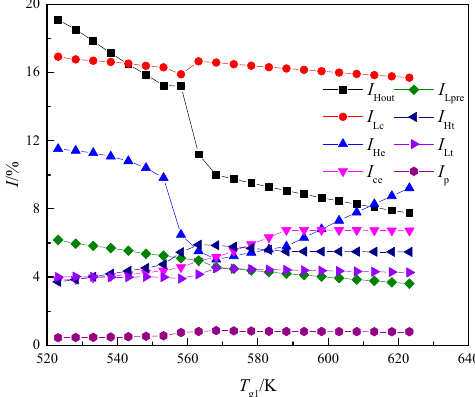
Figure 14. Effects of T g1 on exergy destruction rate for the cyclopentane system.